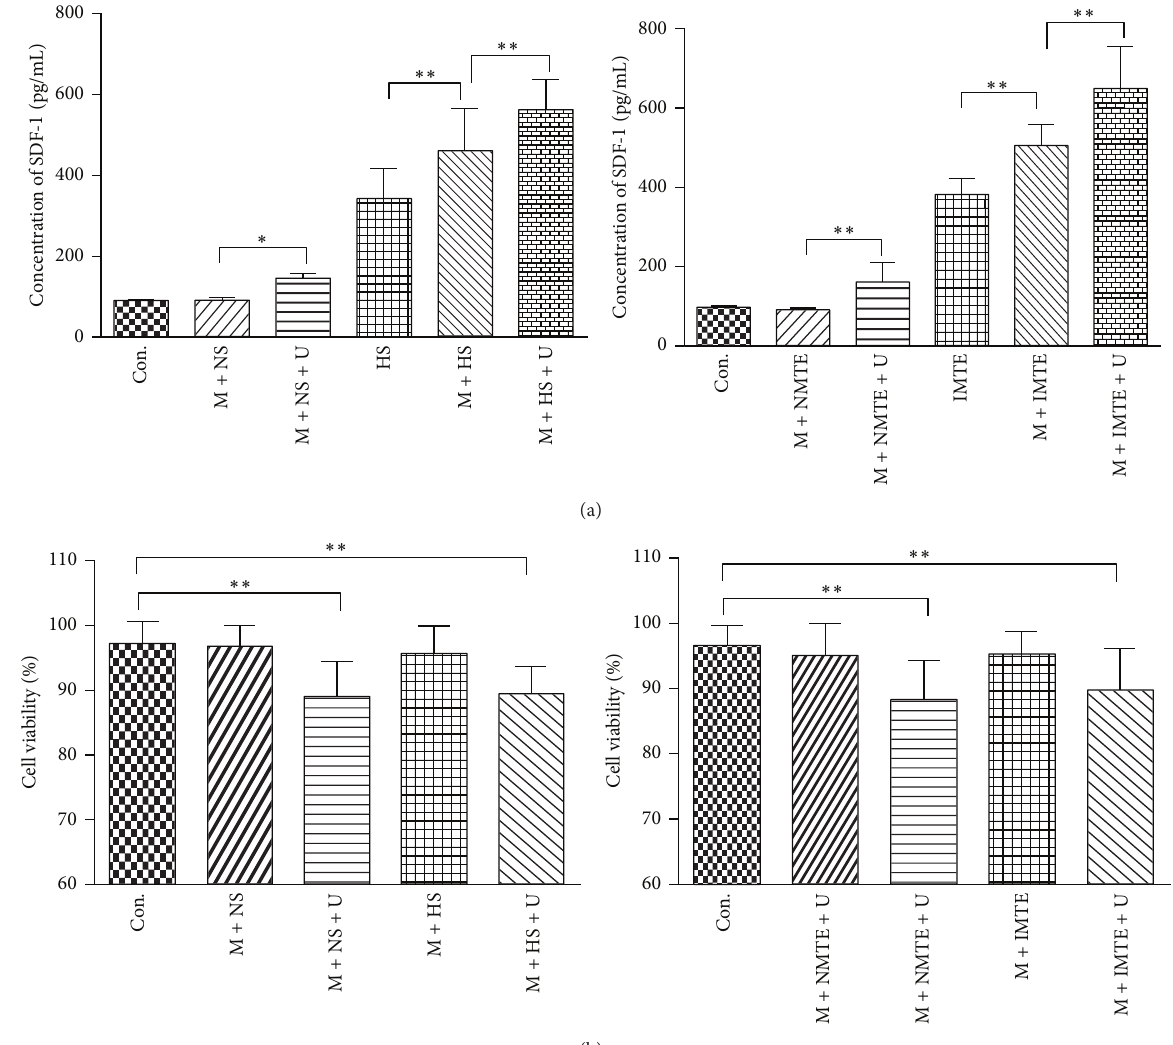
Figure 1: Effect of UTMD on SDF-1 secretion and MSC viability. (a) The assessment of the SDF-1 concentration for the various groups in the supernatant and MTE groups. (b) The assessment of MSC viability for the different supernatant and MTE groups. All values are expressed as the mean ± SD. ∗ 𝑃 < 0.05 ; ∗∗ 𝑃 < 0.01 ; 𝑛 = 6